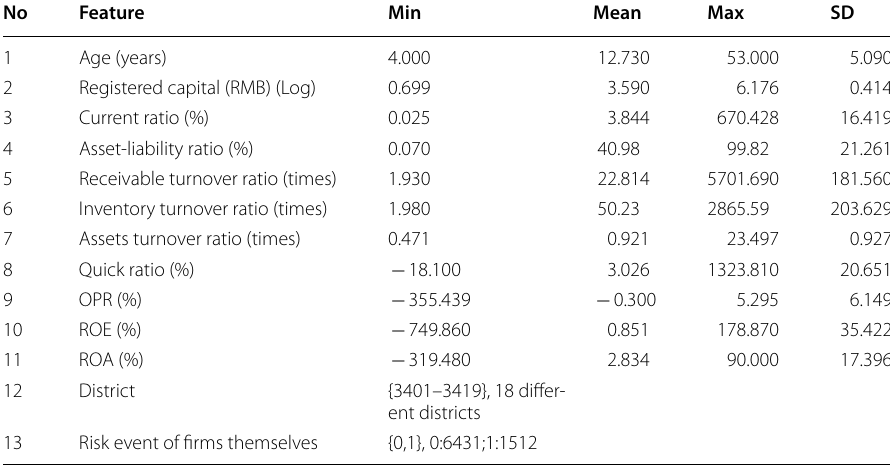
Table 13 Descriptive statistics of basic features on NEEQ SMEs